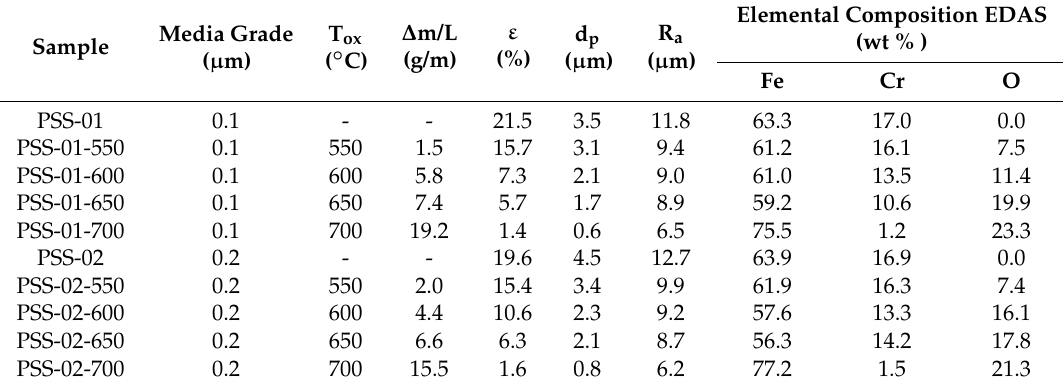
Table 1. Modification after in-situ oxidation of PSS supports with diverse commercial